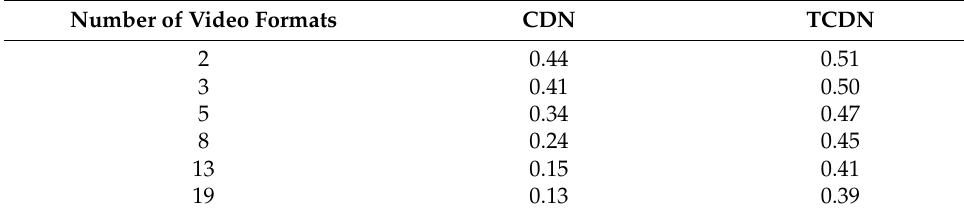
Table 7. Table of hit